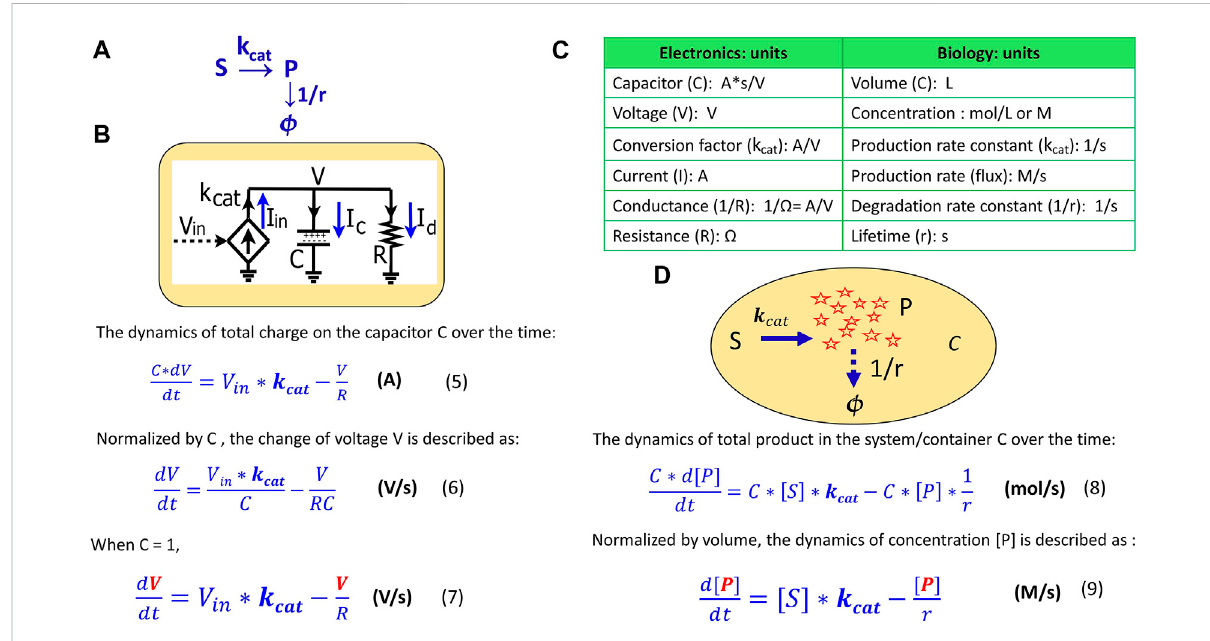
FIGURE 2 The mapping of an elementary biochemical reaction to an equivalent electronic circuit. (A) An example of a simple biochemical reaction whereinsubstrateSisconvertedtoproductPatarateconstantof k cat (1/s)whiletheproductalsodecaysatarateconstantof1/r(1/s). (B) AsimpleRC circuit in the context of the chemical reaction. (C) Translation of electronic variables into biochemical kinetics in a reaction. (D) The same biochemical reaction taking place in a container or a cell with a volume of C. The capacitance of a capacitor is normally set C = 1 A*s/V, which represents a volume-normalized container in a system (per L). Some important equations are summarized in this fi gure for